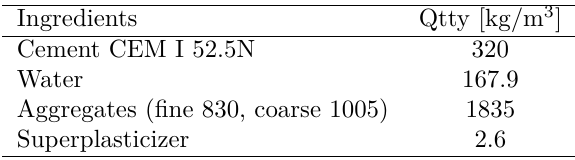
Table 1. Concrete composition